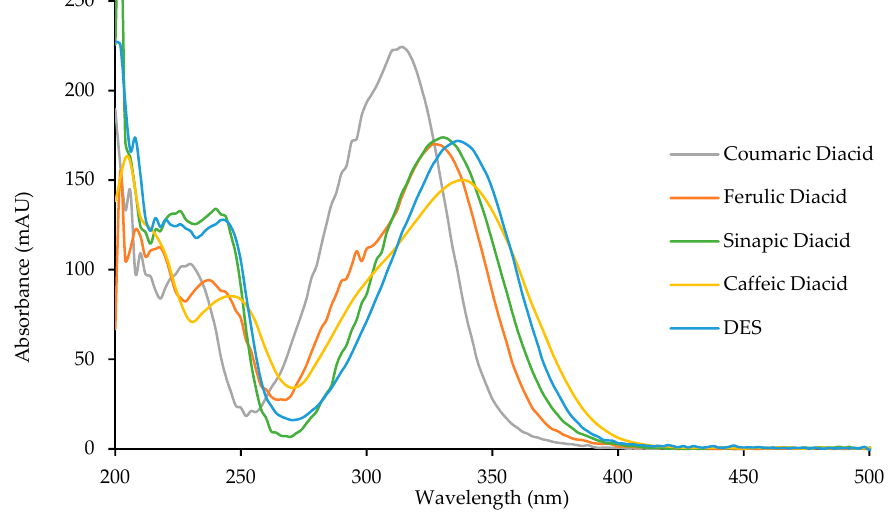
Figure 6. UV spectra of p -hydroxycinnamic diacids and DES.